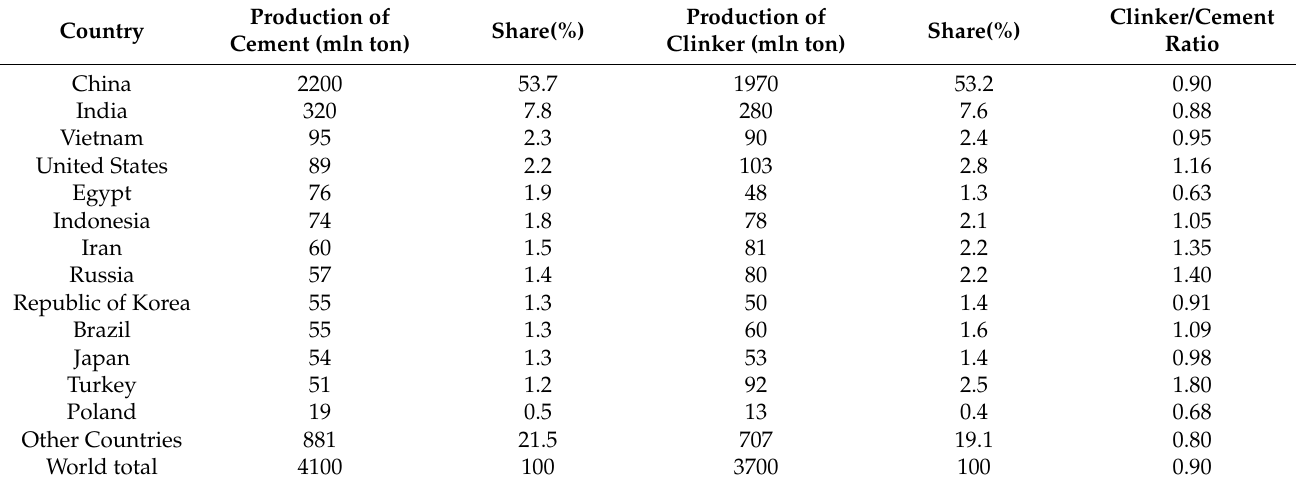
Table 1. World production of cement and clinker in 2019